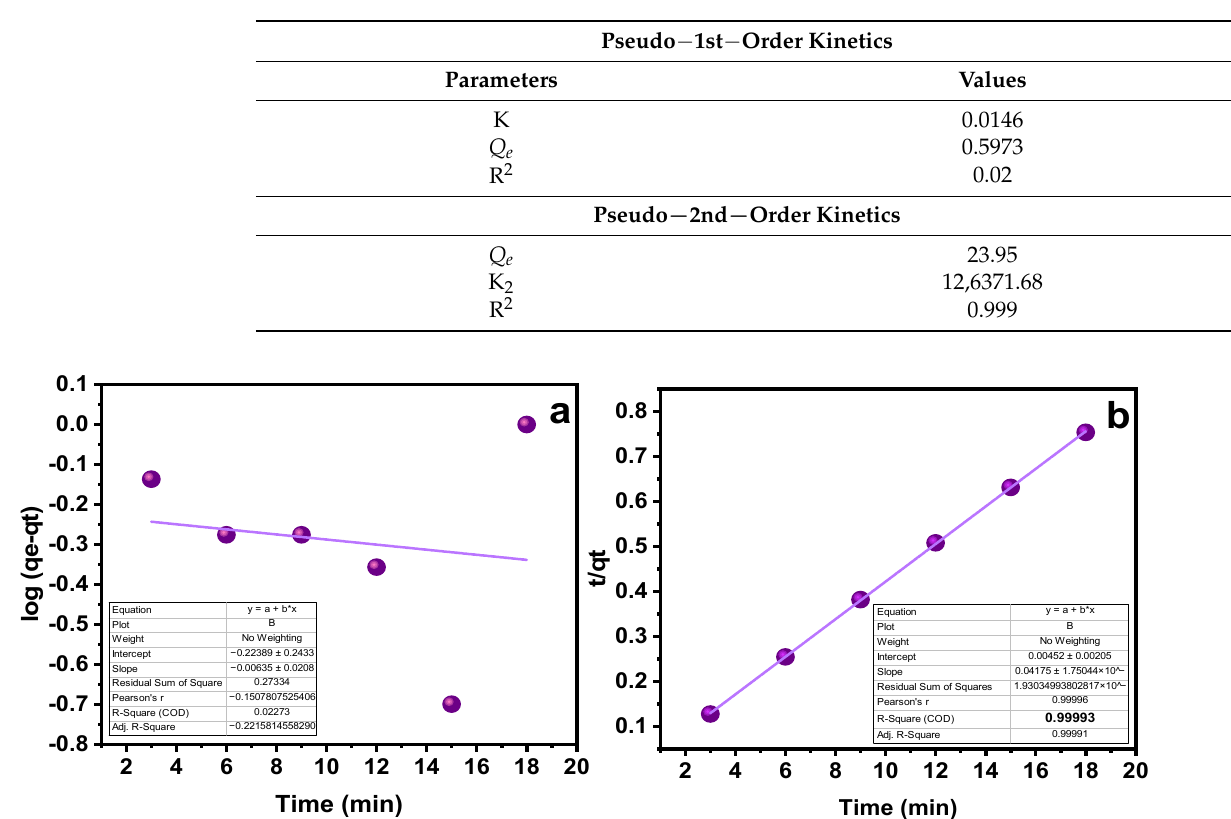
Table 1. Kinetic Parameters for Pseudo − 1st − order kinetics and Pseudo − 2nd − order kinetics.